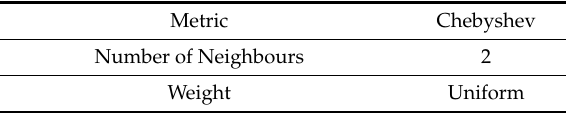
Table 3. Parameters of the k-nearest neighbours